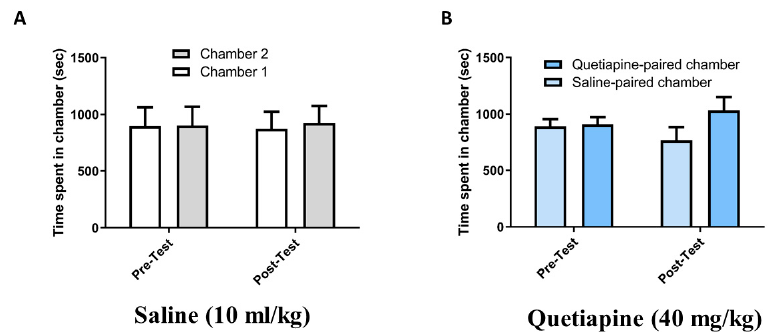
Figure 1. ( A ) Time spent in chamber 1 compared with chamber 2 during the pretest and post-test in the control group. ( B ) Time spent in the quetiapine-paired chamber compared with the saline-paired chamber during the pretest and post-test in the Quet-40 group (treated with quetiapine 40 mg/kg). Values are shown as means ± standard errors of the means.